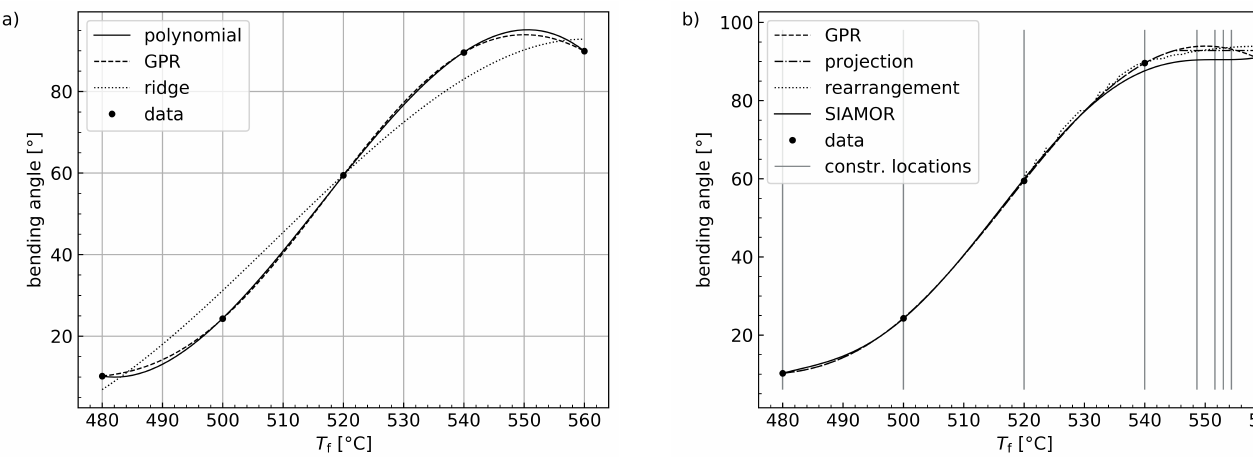
Figure 3. 1D regression for laser glass bending ( n c = 50). ( a ) Unconstrained regression. Solid: polynomial model ( m = 3), dashed: Gaussian process regression (GPR) with RBF kernel (noise level 10 − 5 ), dotted: polynomial ridge regression ( m = 3, λ = 0.003). ( b ) Monotonic regression, with the solid line resulting from the SIAMOR method (see Sections 2.1–2.3) with degree m = 5. The projection [24] (dash-dotted) and rearrangement [22] (dotted) methods were fed with the dashed GPR curve as a non-monotonic reference